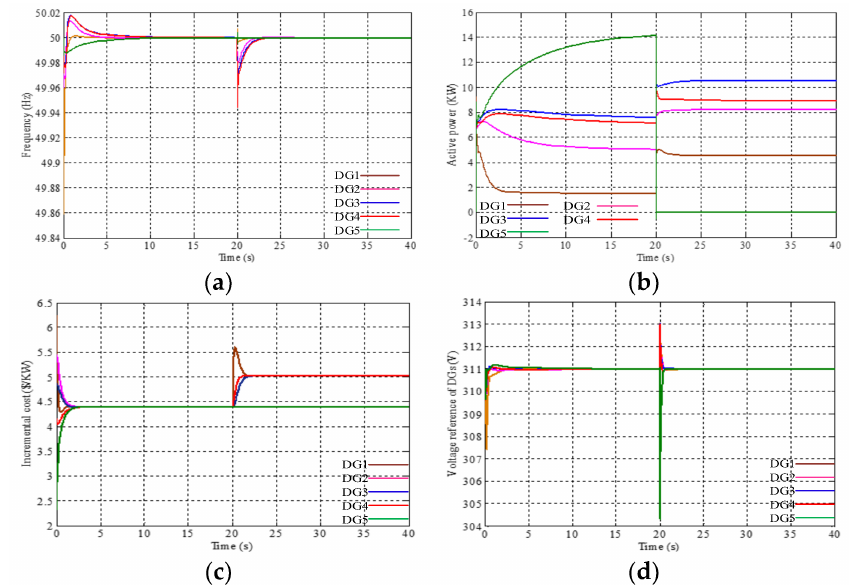
Figure 10. Simulation results of plug-and play function. ( a ) Frequency; ( b ) Active power; ( c ) Incremental cost λ ; ( d ) Voltage reference of